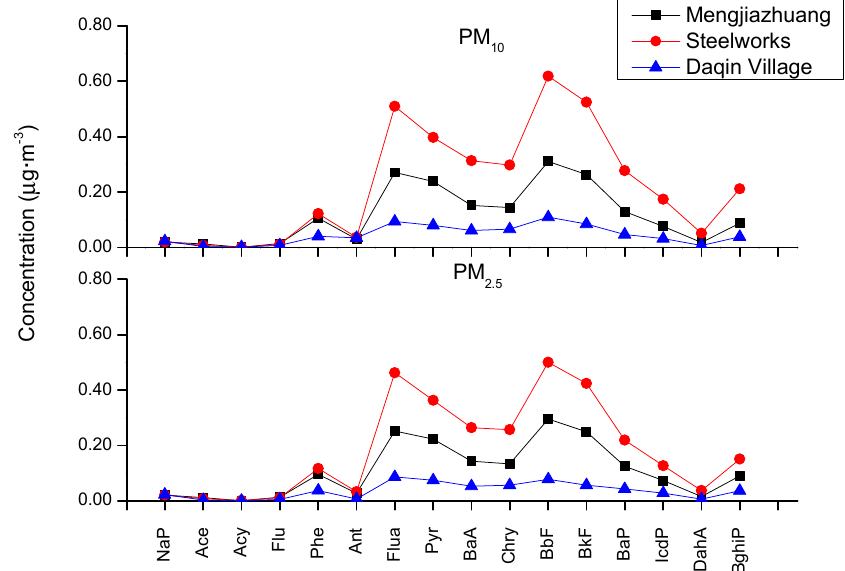
Figure 3. PAHs mass concentration in ambient air particulate matter around the steel plant.